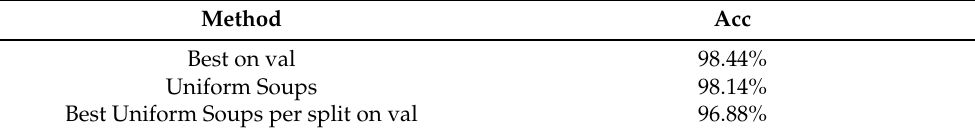
Table 4. Comparison of uniform soups and Best on